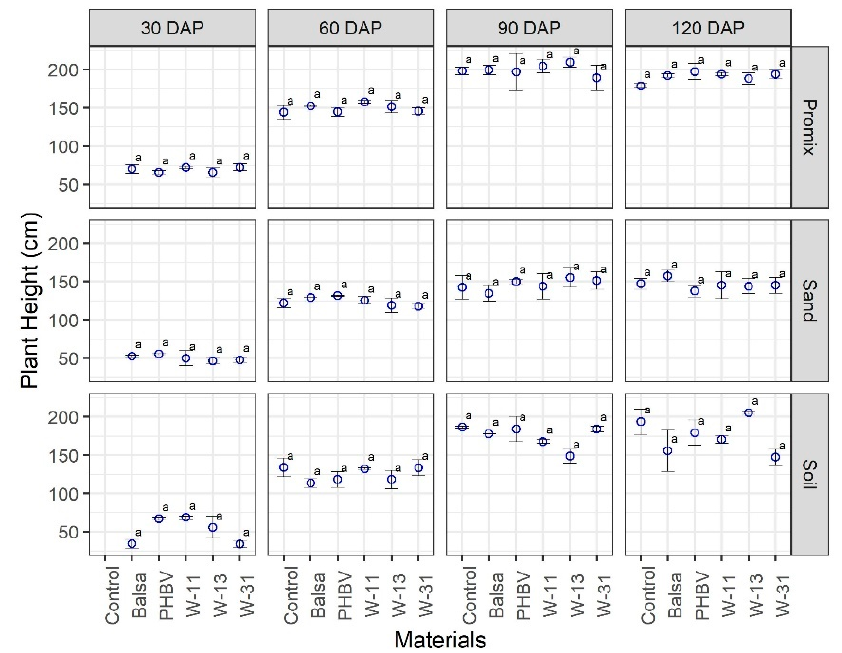
Figure 7. Comparison of maize plant height (cm) in three growing media (Promix, sand, and soil) and four growth stages (30, 60, 90, and 120 days after transplanting (DAP)). Different lowercase letters indicate significant differences at α = 0.05, whereas same letters indicate no significant difference across compared treatments.